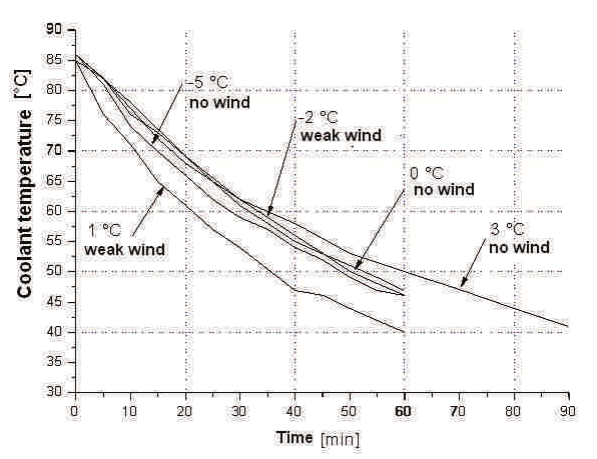
Fig. 2. Coolant temperature reduction after stopping Honda Accord 2.0 engine